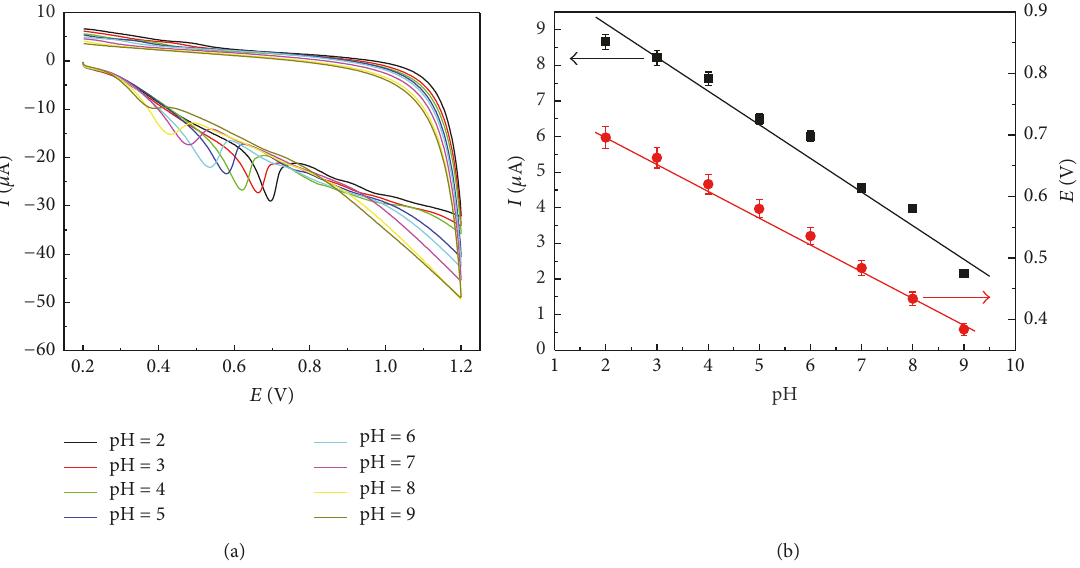
Figure 3: (a) CV curves of 20 𝜇 M trans -resveratrol in 0.04 M BR solution with different pH at the ERGO/GC electrode. Scan rate: 25 mVs −1 . (b) Effect of pH value on oxidation peak current and peak